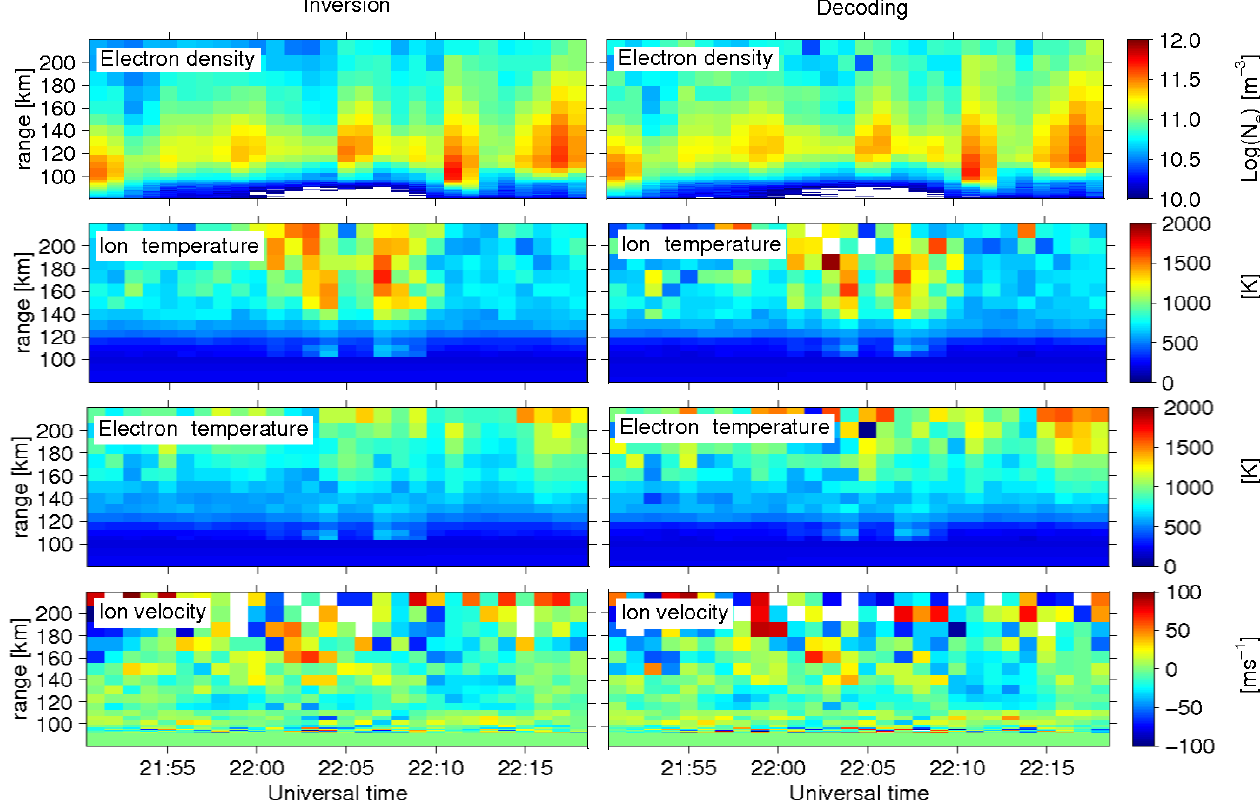
Fig. 4. Real part of 12µs lag from the same experiment as in Fig. 3 (25 November 2006). The ACF value is in arbitrary units, the time resloution is 6s and the range resolution 450m.